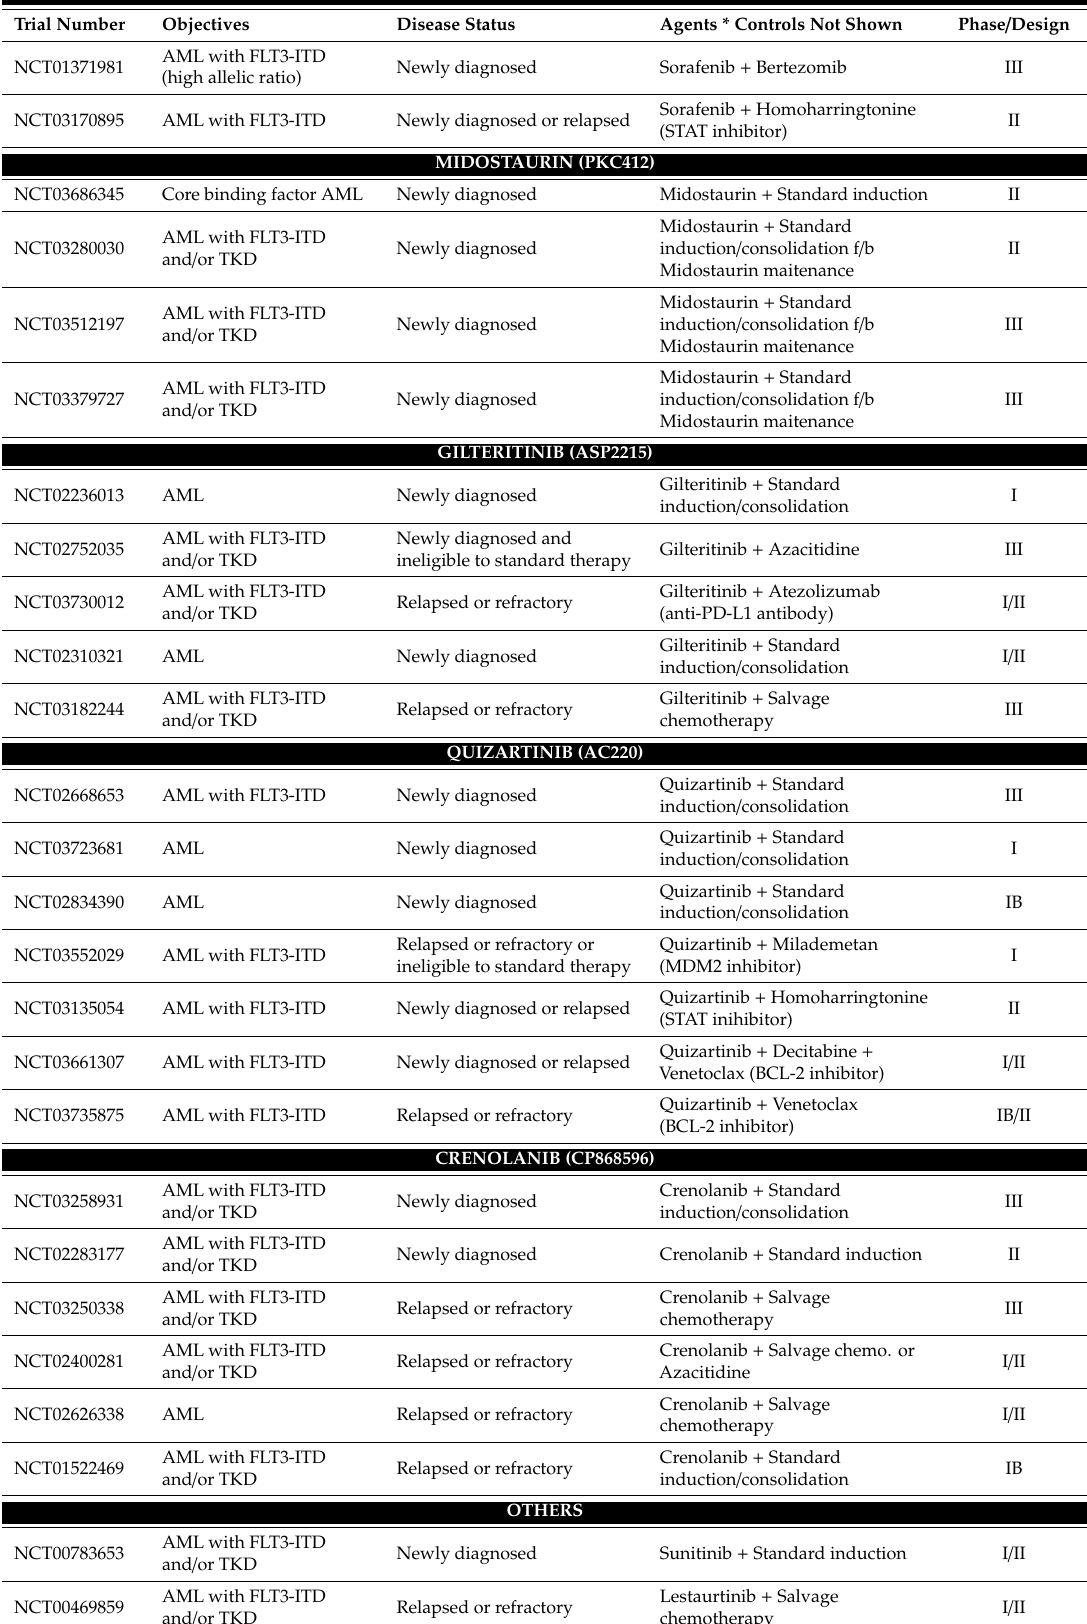
Table 3. Clinical trials of FLT3